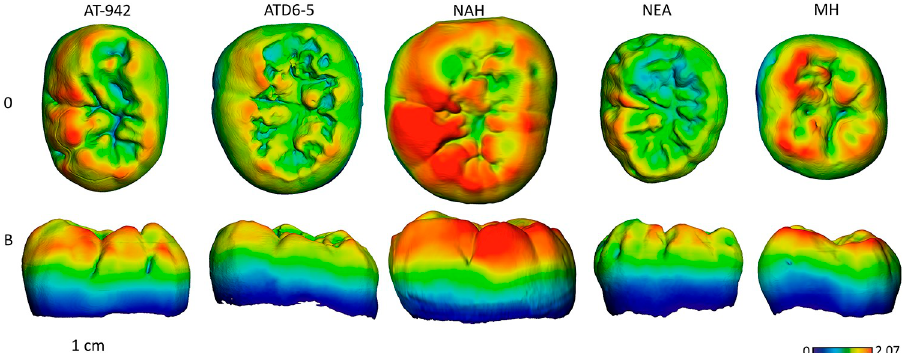
Fig 14. Enamel thickness cartographies of the Atapuerca-SH lower M3 (AT-942) compared with those of Tighenif, H . antecessor (ATD6-5) from Atapuerca-Gran Dolina, Neanderthal and modern human. Topographic thickness variation is rendered by a pseudo-color scale ranging from thinner dark-blue to thicker red. NAH = Tighenif, NEA = Neanderthal (Abri Suard S43) and MH = modern human of European origin (O = occlusal, L = lingual). Scale bar = 2.07 for all specimens. (When needed specimens have been mirrored to the left to match the SH specimen).